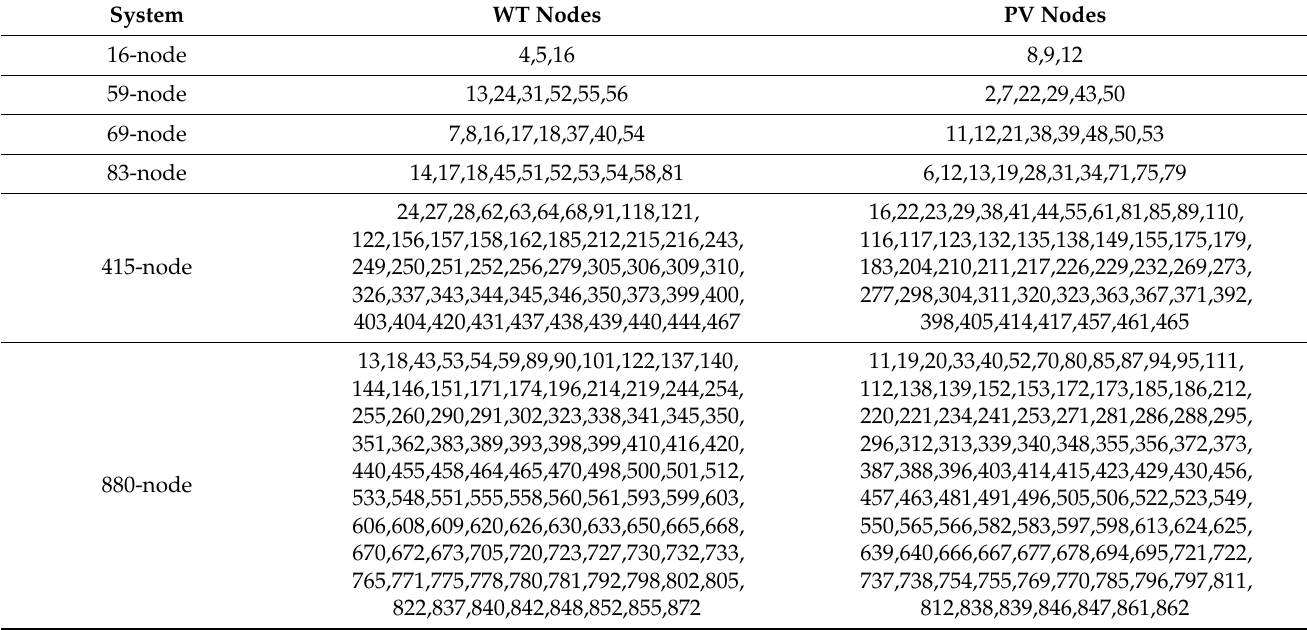
Table 4. Candidate wind turbine (WT) and photovoltaic (PV)